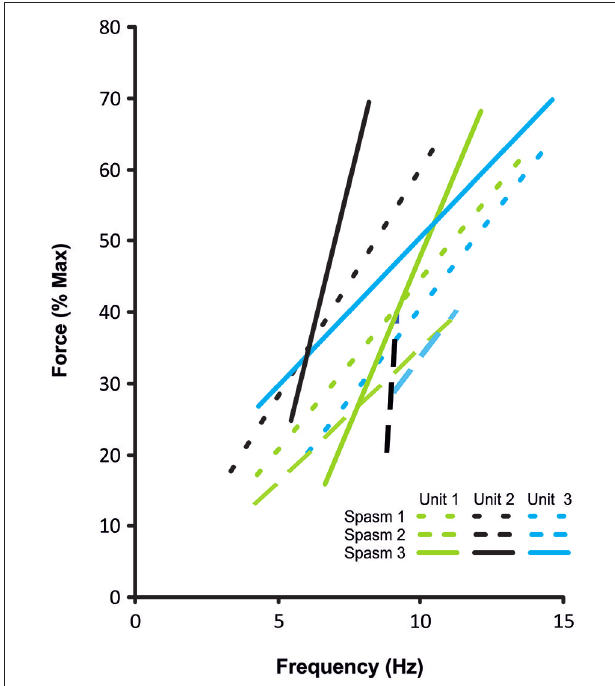
FIGURE 4 | Frequency-force relationship for the 3 coactive units during the force increase of spasm 1, 2 and 3 (dotted, dashed, solid lines, respectively) shown in Figure 3.